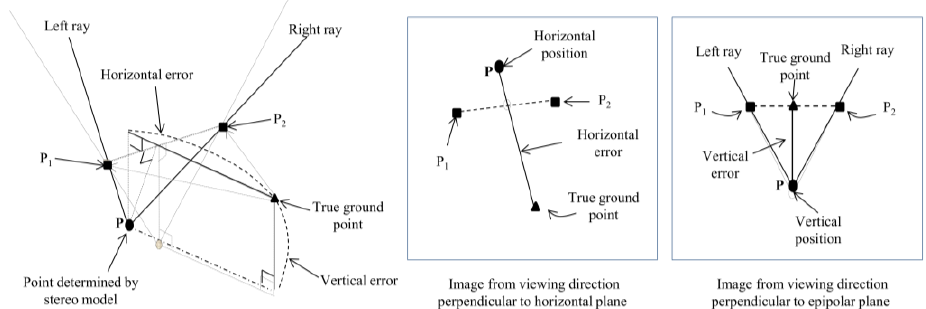
Figure 7. Effects of changes in the BIE angle on the stereo geometry and positioning accuracy (Jeong and Kim,